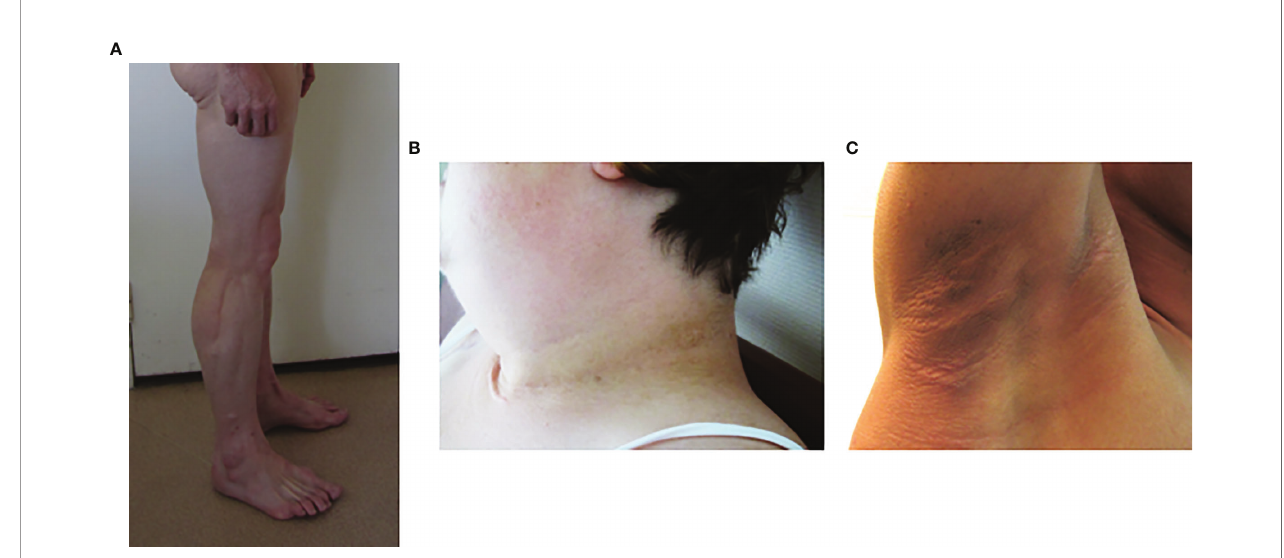
FIGURE 3 | Phenotypic features of lipodystrophy syndromes. (A) Muscular hypertrophy and lipoatrophy of limbs in Type 2 Familial Partial Lipodystrophy (Dunnigan syndrome). (B, C) Cervical and axillary acanthosis nigricans in patients with lipodystrophy due to LMNA (B) or BSCL2 (C) pathogenic